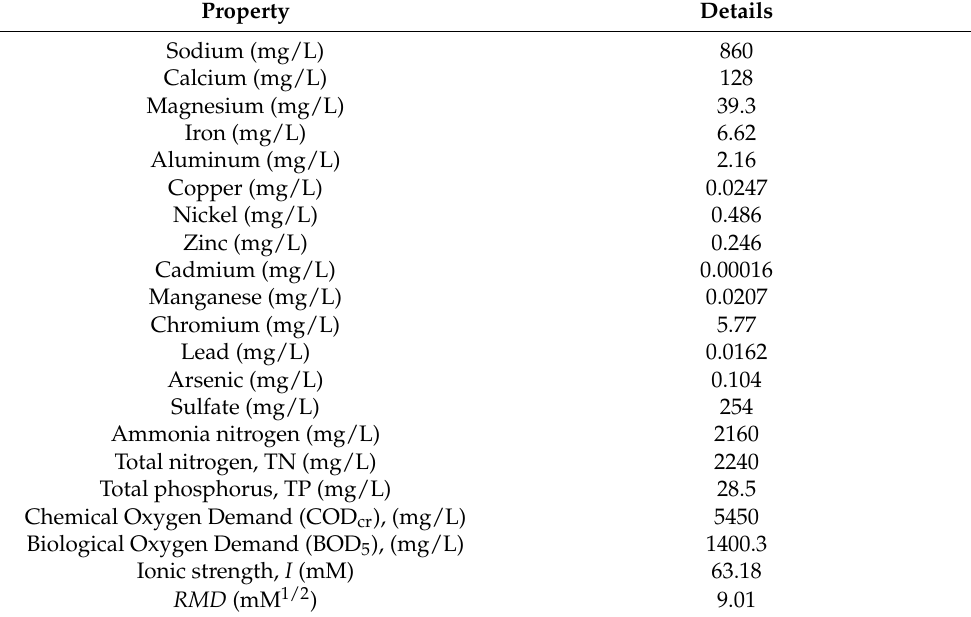
Table 2. Chemical properties of the MSW landfill leachate used in this study.